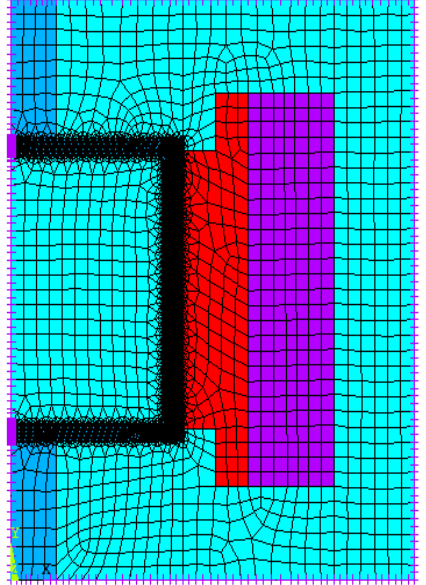
Figure 8. Finite element model of radial MR valve.